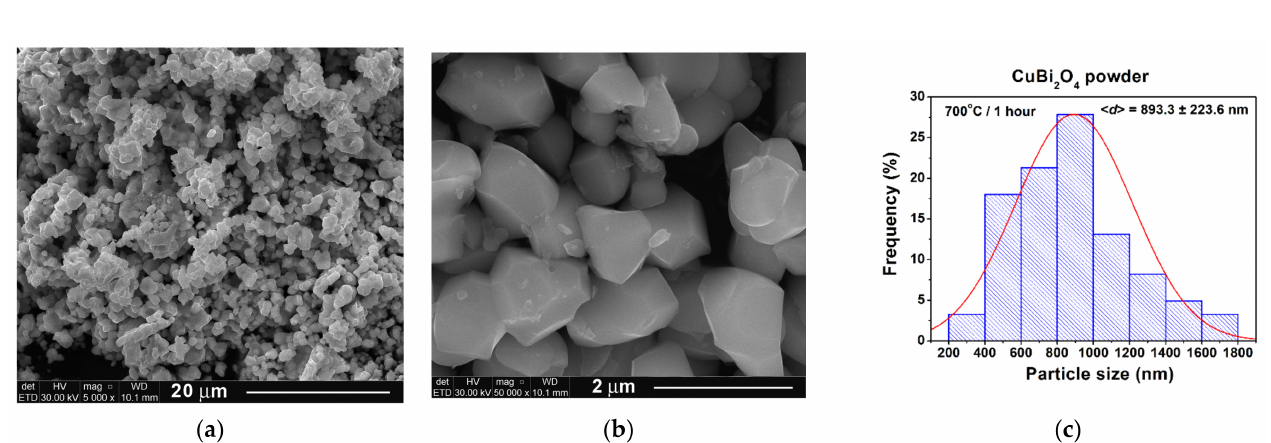
Figure 4. FE-SEM images the CuBi 2 O 4 powder calcined at 700 ◦ C for 1 h: ( a ) low magnification ( × 5000) overall view, ( b ) high magnification view ( × 50,000), and ( c ) histogram indicating the particle size